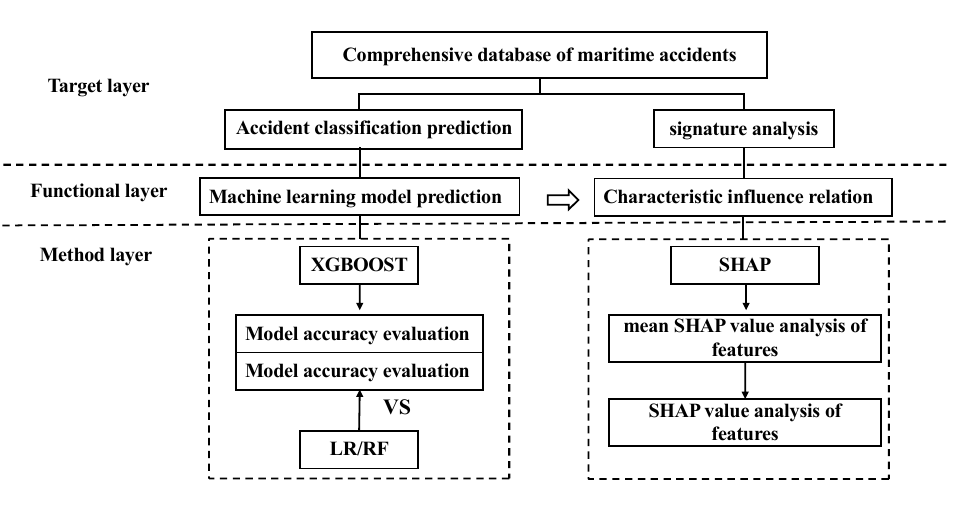
Figure 5. Technological pathway.